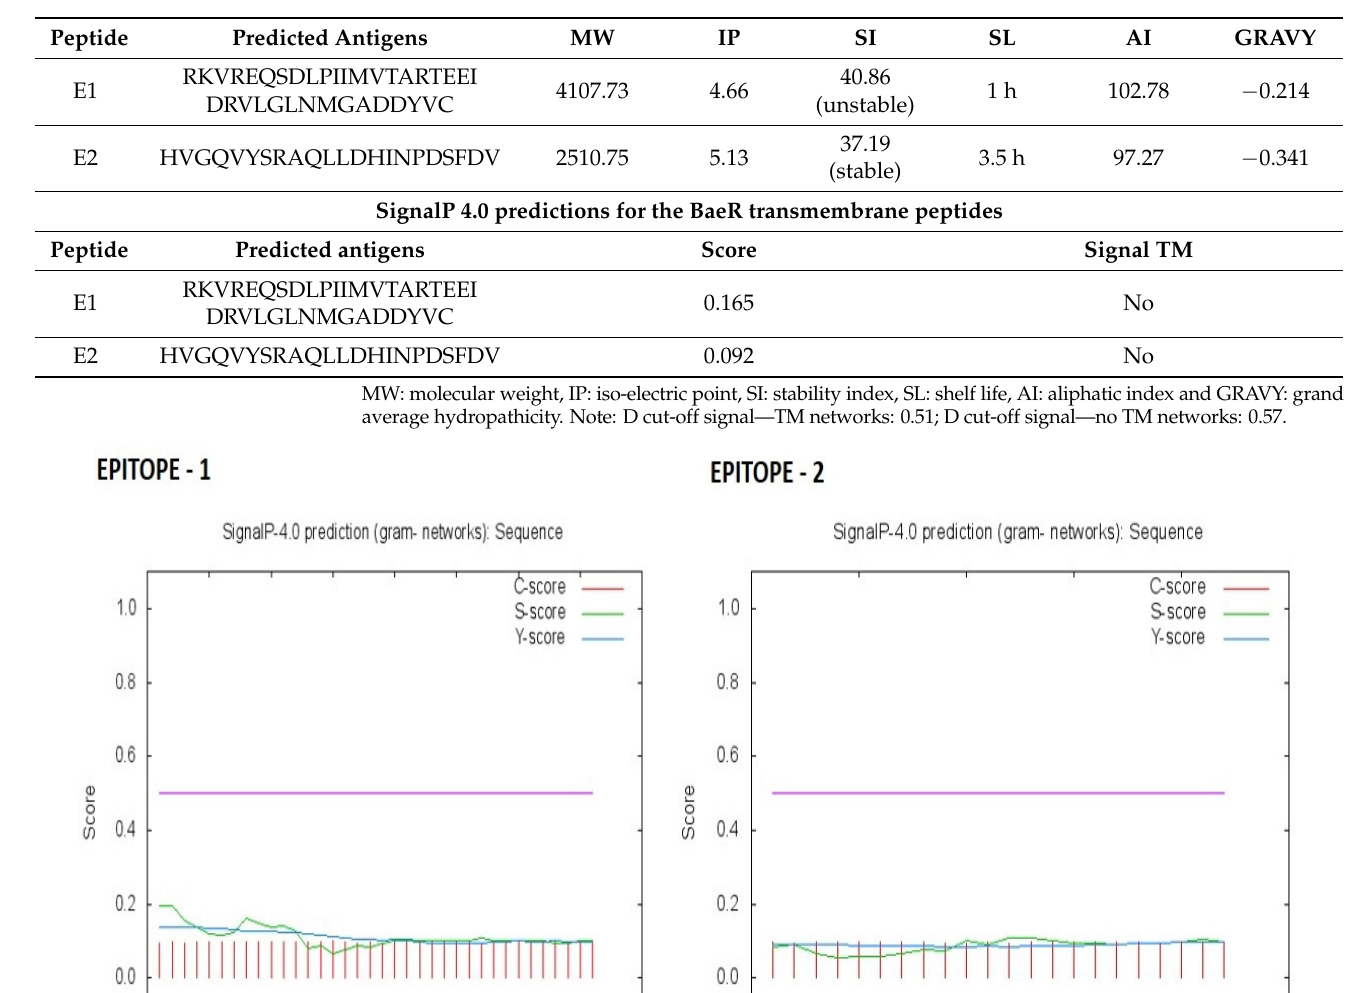
Table 4. Physio-chemical properties and SignalP 4.0 predictions for BaeR epitopes.